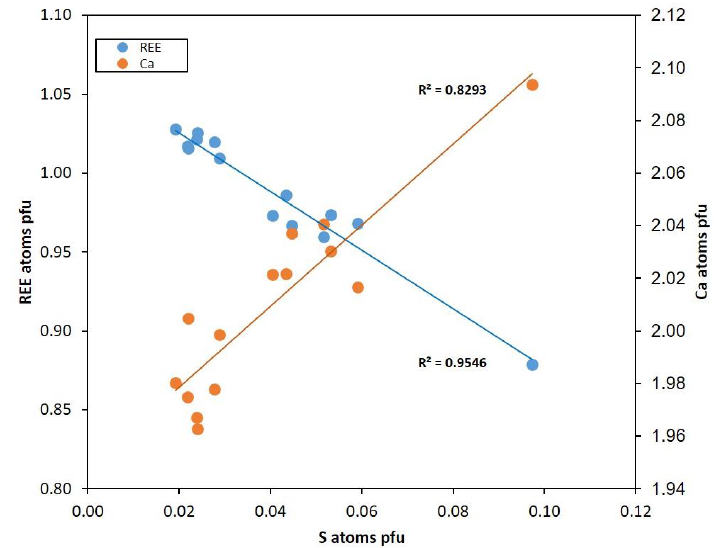
Figure 6. Compositional variations in kesebolite-(Ce). The straight lines are obtained from linear fits of the data.